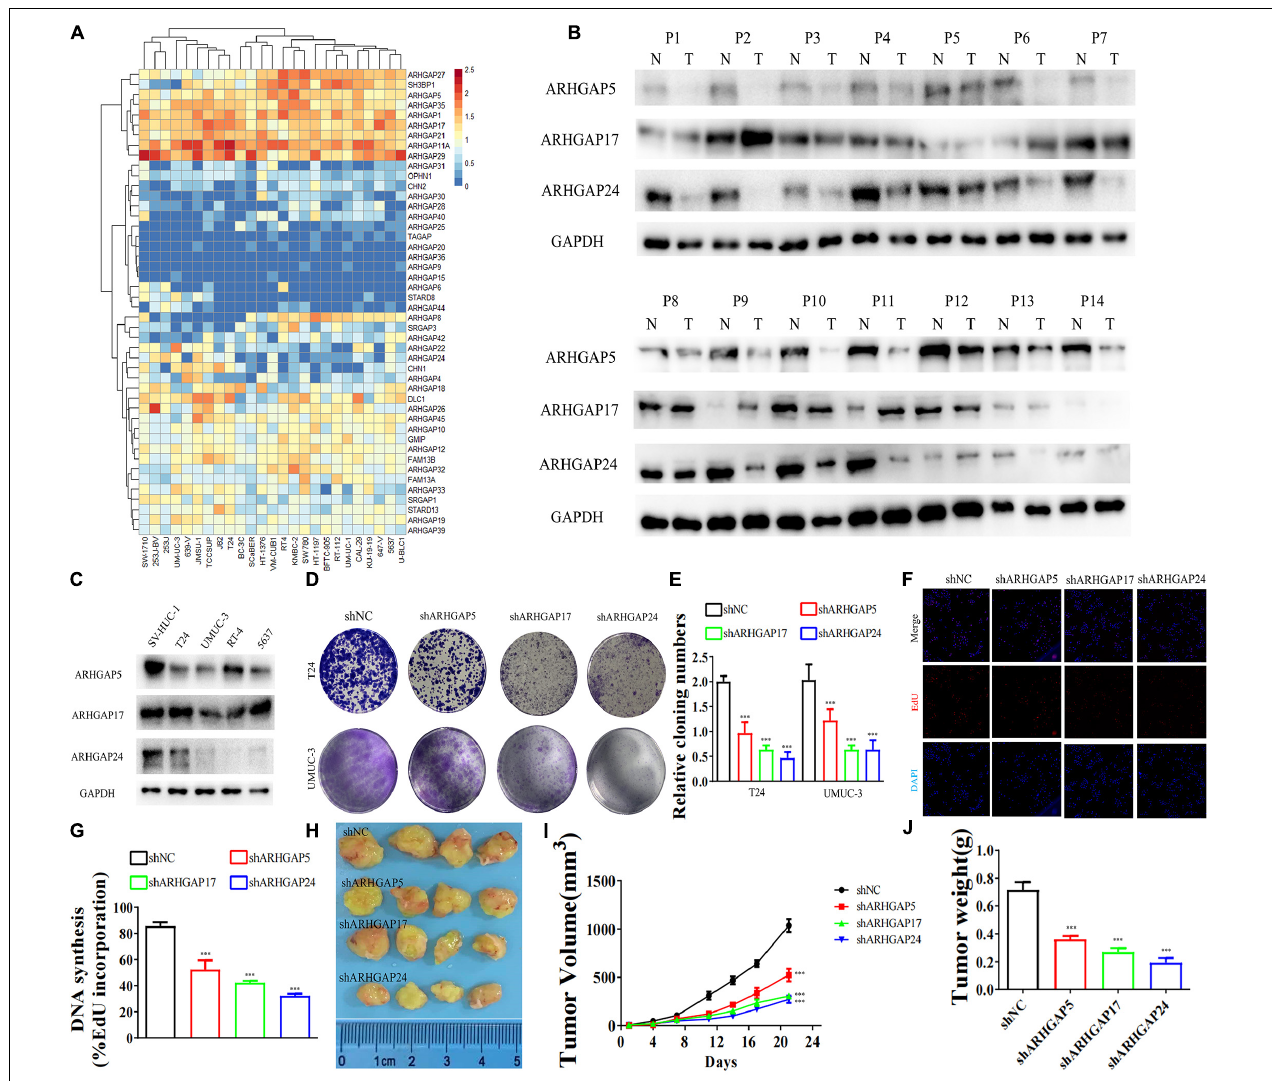
FIGURE 5 | Knockdown of ARHGAP5-, ARHGAP17-, and ARHGAP24-suppressed BC cell proliferation in vivo and in vitro . (A) System analysis of expression of ARHGAP family gene in BCa cancer cell lines in the CCLE database. (B) ARHGAP5, ARHGAP17, and ARHGAP24 expression in seven pairs of low-grade BCa and seven pairs of high-grade BCa; GAPDH serves as a loading control. (C) ARHGAP5, ARHGAP17, and ARHGAP24 expression in four bladder transitional cell carcinoma cell lines (RT4, UM-UC-3, T24, and 5637) compared with immortalized epithelium cell line (SV-HUC-1). (D,E) Cloning formation of T24, UMUC-3, and ARHGAP5, ARHGAP17, and ARHGAP24 knocking down T24, UMUC-3 (*** p < 0.001 versus shNC). (F,G) 5-Ethynyl-2 (cid:48) -deoxyuridine (EdU) assay of T24 and shARHGAP5-, ARHGAP17-, and ARHGAP24-transfected T24 (*** p < 0.001 versus shNC). (H) Tumor growth size of subcutaneous T24 tumors transfected with shNC or shARHGAP5, ARHGAP17, and ARHGAP24 21 days after tumor implantation. (I) Tumor growth curve of subcutaneous T24 tumors transfected with shNC or shARHGAP5, ARHGAP17, and ARHGAP24 in 21 days of tumor implantation. (J) Average weights of tumors from shNC and shARHGAP5, ARHGAP17, and ARHGAP24 are shown in the histogram. Error bars indicate